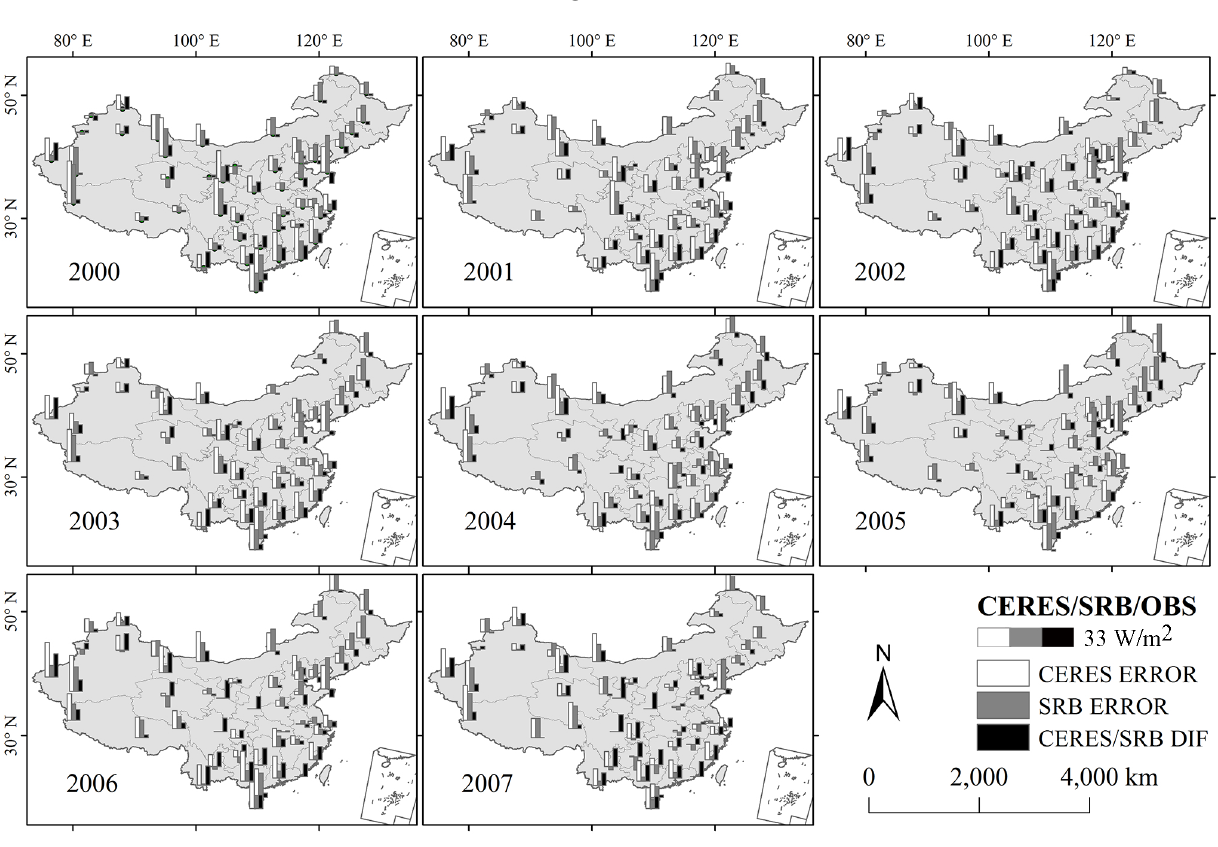
Figure 7. Spatial distribution of annual mean errors in surface net radiation generated from the CERES and the SRB products from 2000 to